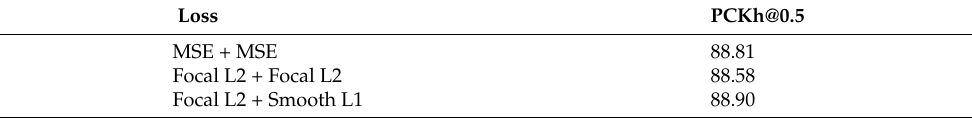
Table 6. Ablation study of different loss functions.